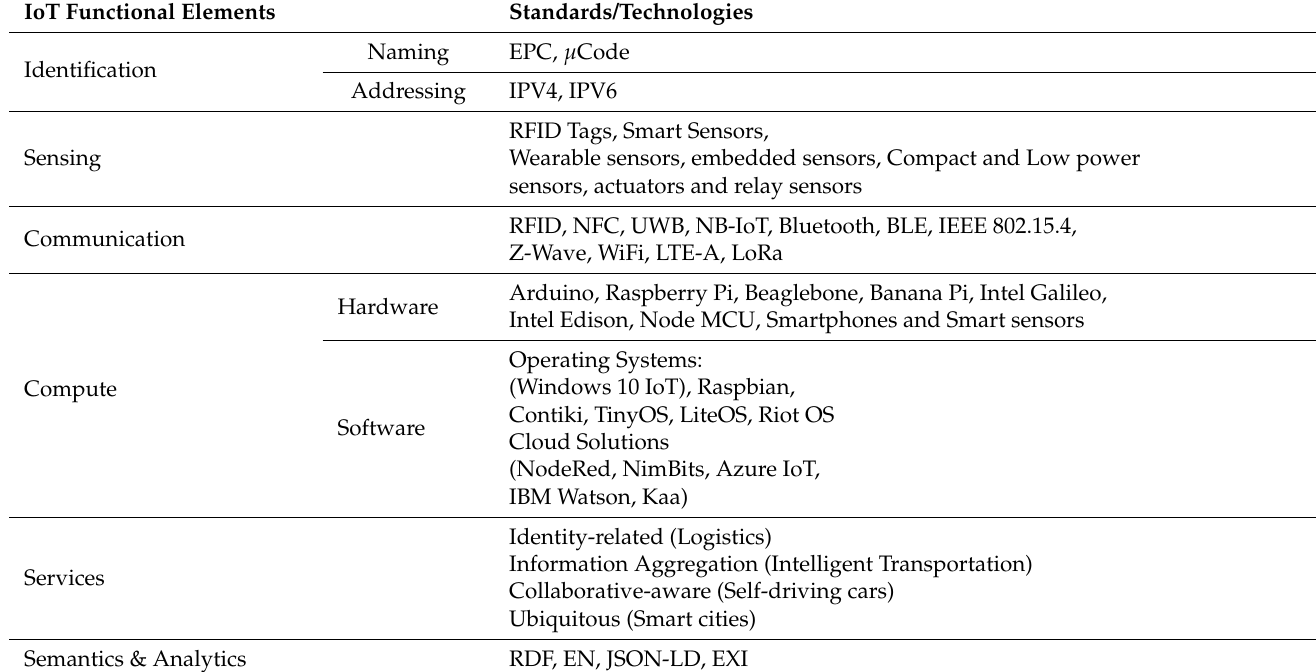
Table 6. IoT functional elements and associated technologies overview